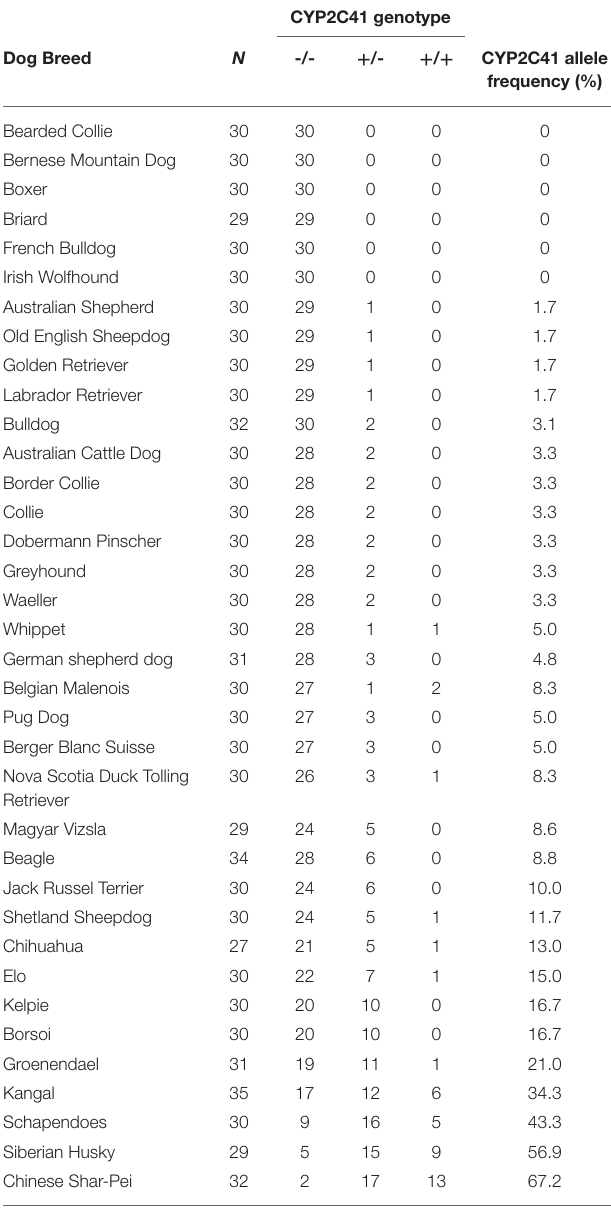
TABLE 5 | CYP2C41 genotyping of 1,089 subjects from 36 dog breeds. CYP2C41